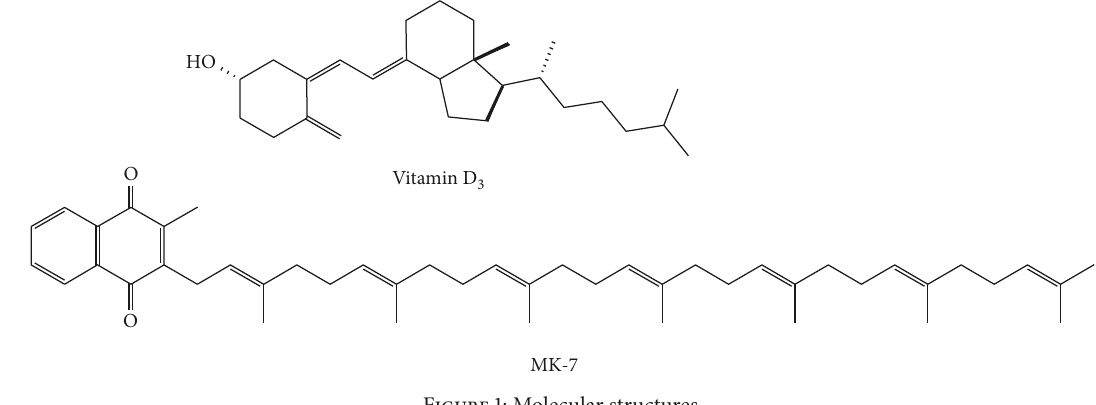
Figure 1: Molecular